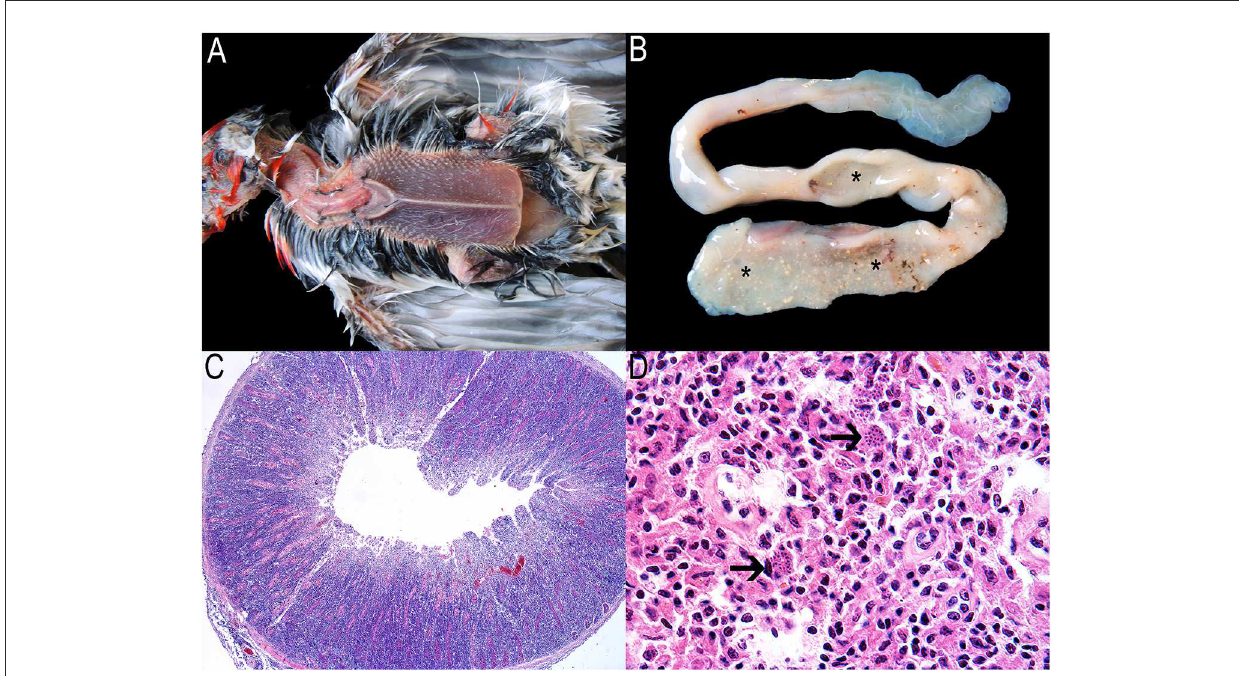
FIGURE3 Atoxoplasmosis associated with lymphoproliferative diseases in songbirds. Macroscopic and microscopic findings. (A) Red-crested cardinal in poor physical health evidenced by marked atrophy of the pectoral muscles. (B) Evident thickening of the initial portion of the small intestine (asterisks). (C) Small intestine. Intense lymphocytic proliferation obliterating the entire intestinal mucosa and sometimes extending to the serosa. Hematoxylin and eosin 40X. (D) Spleen. Numerous small merozoites within the cytoplasm of macrophages (arrows). Hematoxylin and eosin 1,000X.